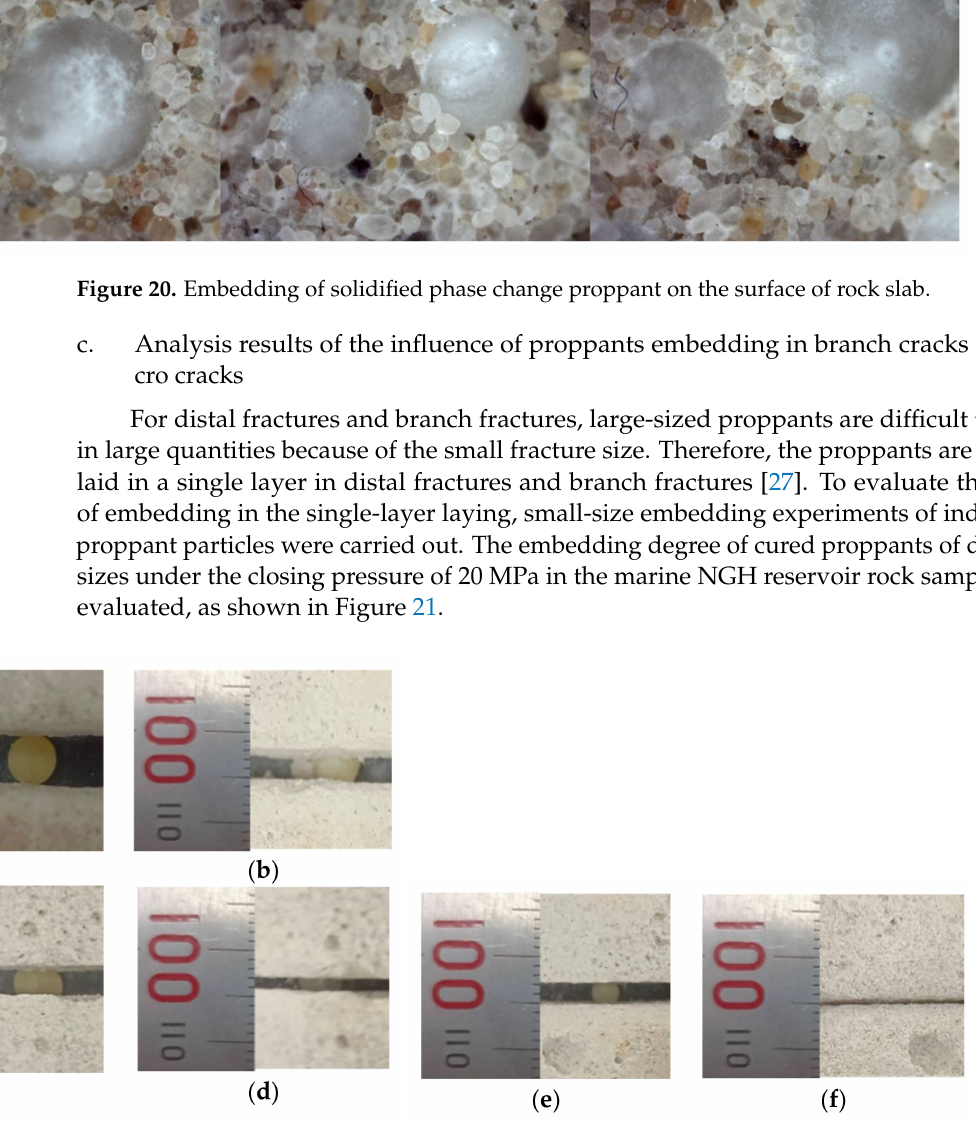
Figure 21. Experimental results of small-size embedding of medium-size proppant particles. (( a , b ) are the embedding degree of proppants with a size of 4.5 mm in the fracture under and not under the closure stress; ( c , d ) are the embedding degree of proppants with a size of 3 mm in the fracture under and not under the closure stress; ( e , f ) are the embedding degree of proppants with a size of 2.5 mm in the fracture under and not under the closure